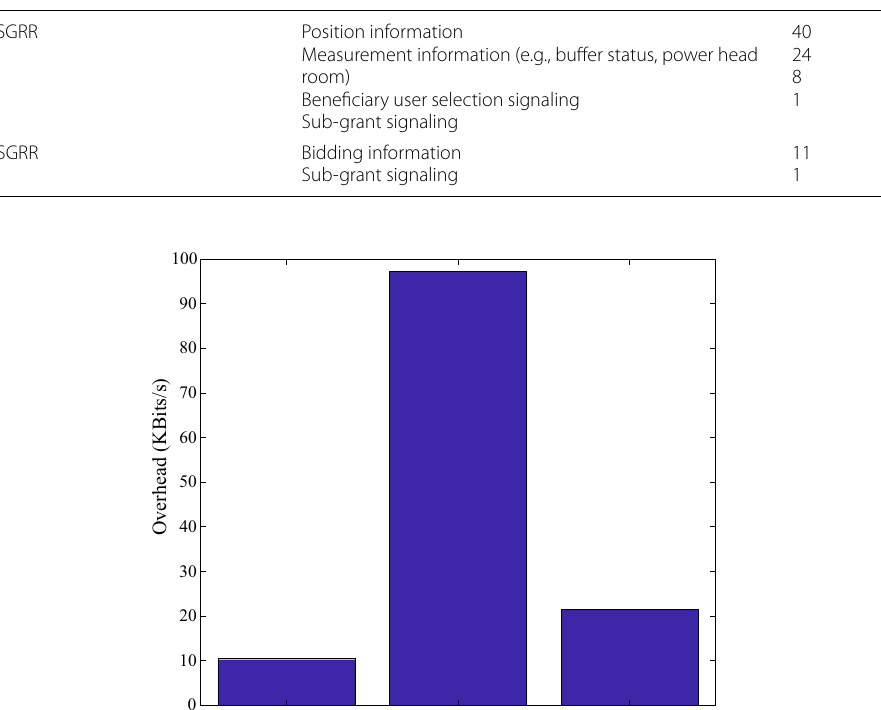
Table 4 An illustration of overhead components and size in the OSGRR and DSGRR Selection algorithm